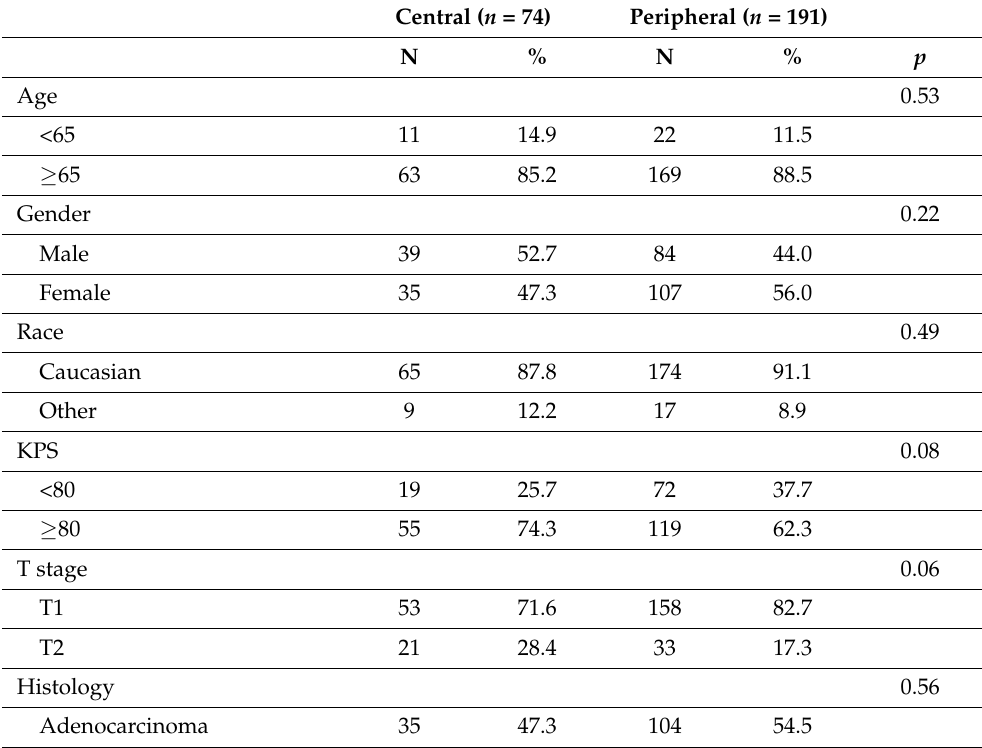
Table 1. Baseline characteristics prior to propensity score